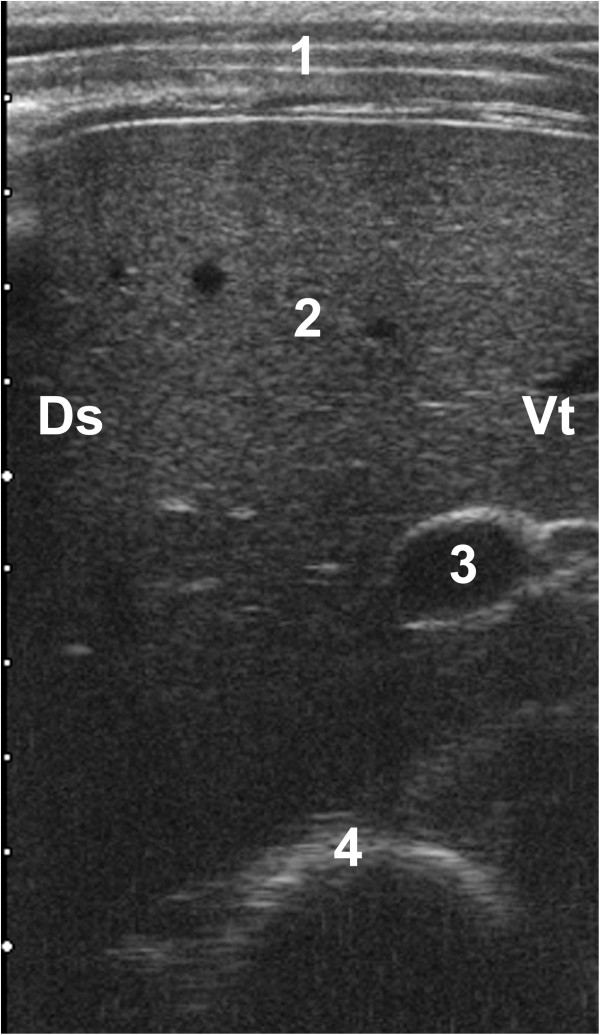
Ultrasonogram of the omasum. Ultrasonogram of the omasum and liver of a 27-day-old Swiss Braunvieh calf with ruminal drinking syndrome. The 5.0-MHz linear transducer was held on the right side parallel to the ribs in the 8th intercostal space. The omasum is seen medial to the liver as a crescent-shaped echo with the convex side toward the transducer. 1 Abdominal wall, 2 Liver, 3 Portal vein, 4 Omasum, Ds Dorsal, Vt Ventral.